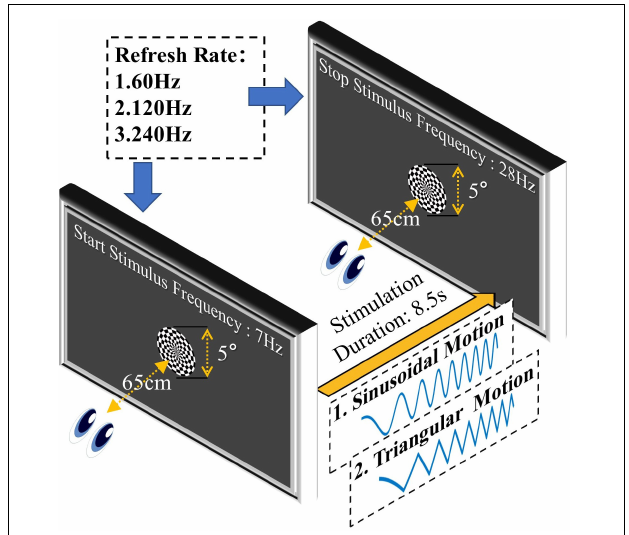
FIGURE 1 | Stimulation parameter settings of the paradigm. The motion stimulus was modulated by sinusoidal or triangular sweep signals. The duration of stimulation was set at 8.5 s, the start frequency was set at 7 Hz, the end frequency was set at 28 Hz, the viewing angle of the stimulus was set at 5 ◦ , and the motion amplitude was set at 0.6 ◦